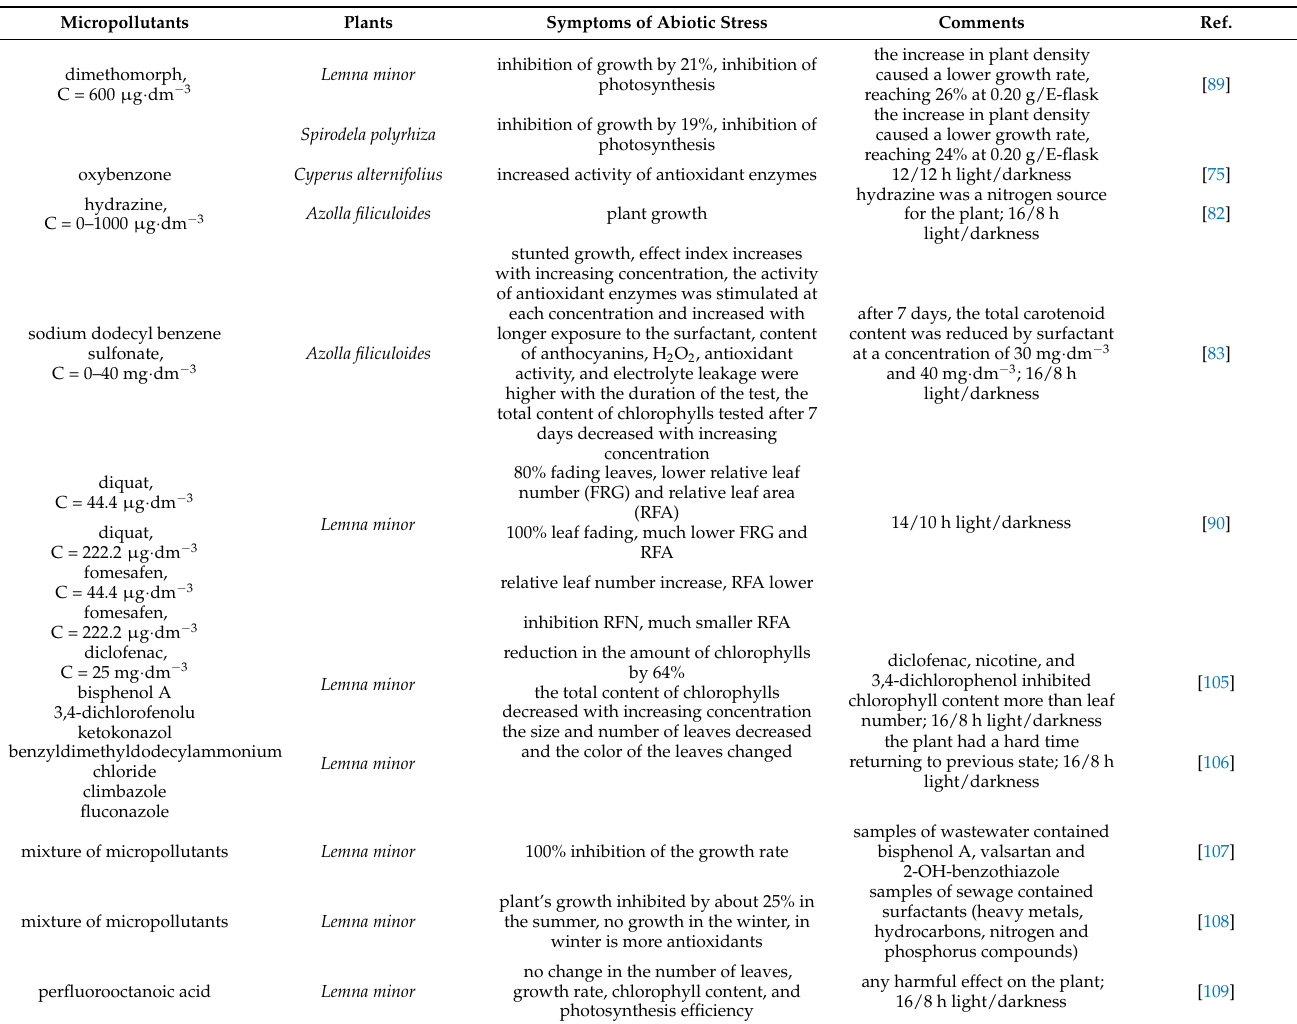
Table 3. The impact of micropollutants on aquatic